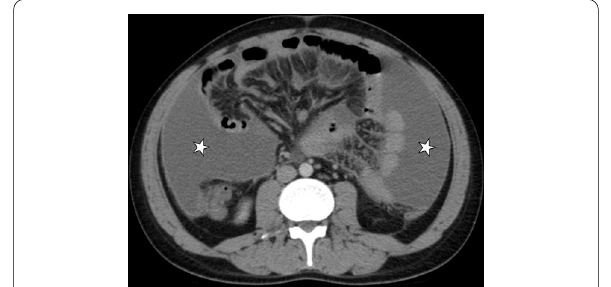
Fig. 25 Transverse CT image with intravenous contrast of a 29-year-old male. Massive ascites is indicated in the abdomen cavity (stars). The peritoneum’s thin linear contrast enhancement is also noted. Tuberculous peritonitis